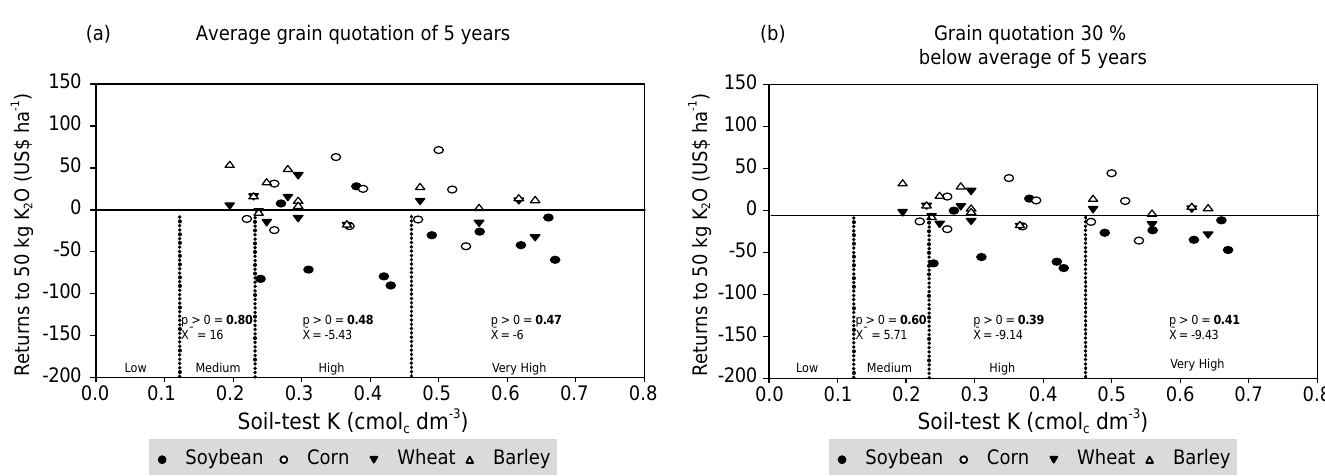
Figure 2. Net returns from K fertilization for different interpretation classes and prices of commodities and fertilizers. Quotation for soybean, corn, wheat, and barley: US$ 225.50, 101.50, 149.28, and 141.71 Mg -1 (a); and US$ 157.71, 71.14, 104.57 and 99.14 Mg -1 (b). Quotation for K fertilizer: US$ 359.43 Mg -1 K 2 O. (US$ = R$ 3.50). *: p>0 = Ratio of the number of trials with a positive increase to total trials in each interpretation